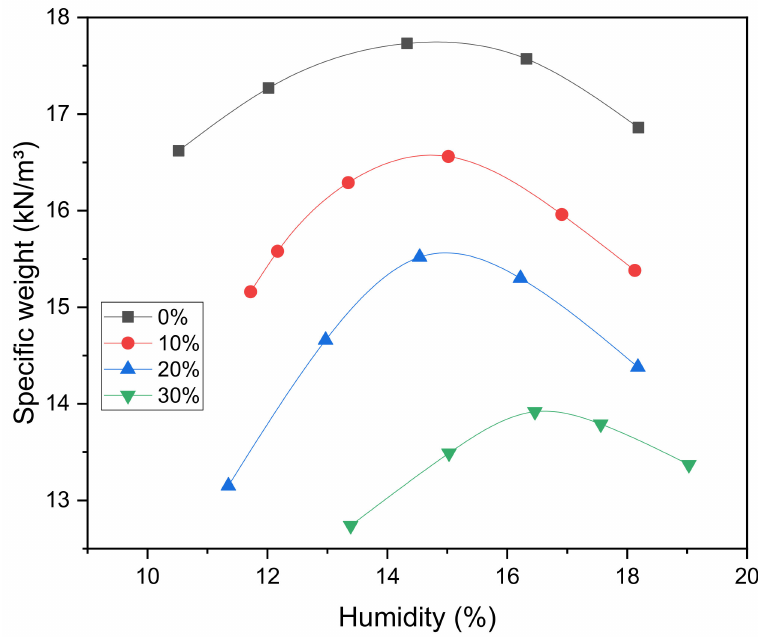
Figure 4. Compaction curves and optimum moisture of mixtures. Percentages (%) indicate the amount of water content in each mixture (0%, 10%, 20% and